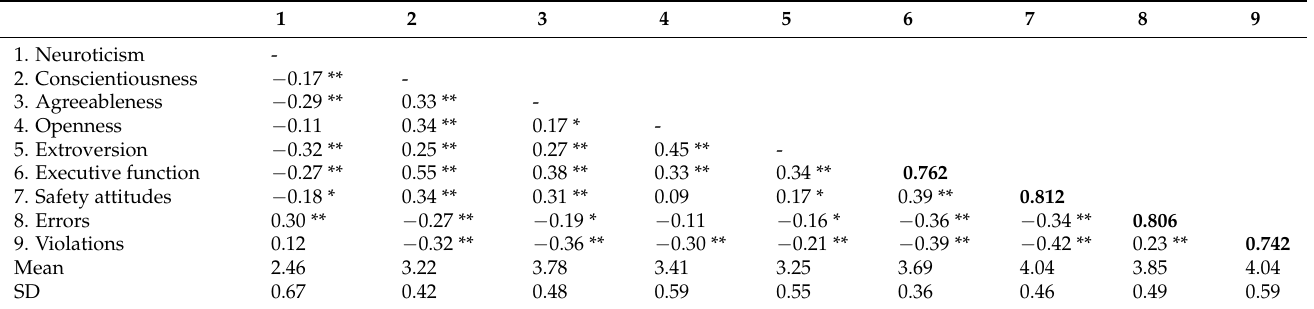
Table 3. Means of and correlations among major